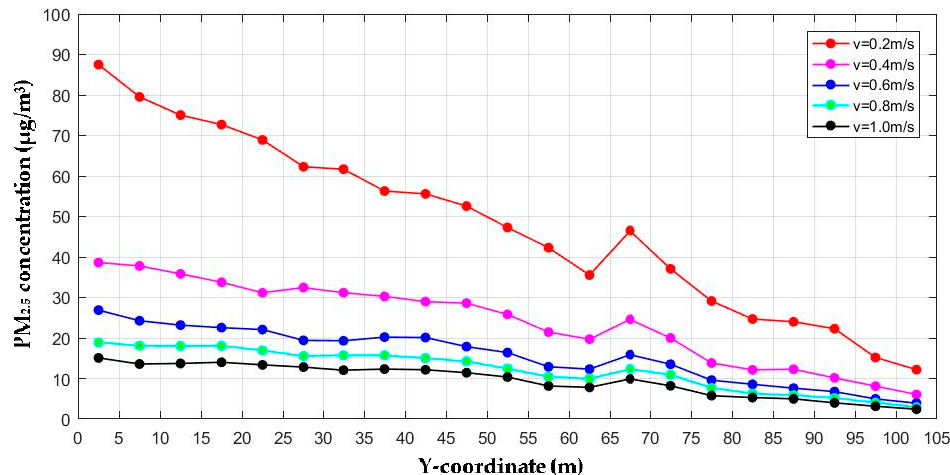
Figure 9. PM 2.5 concentration profiles for different inlet air velocity.